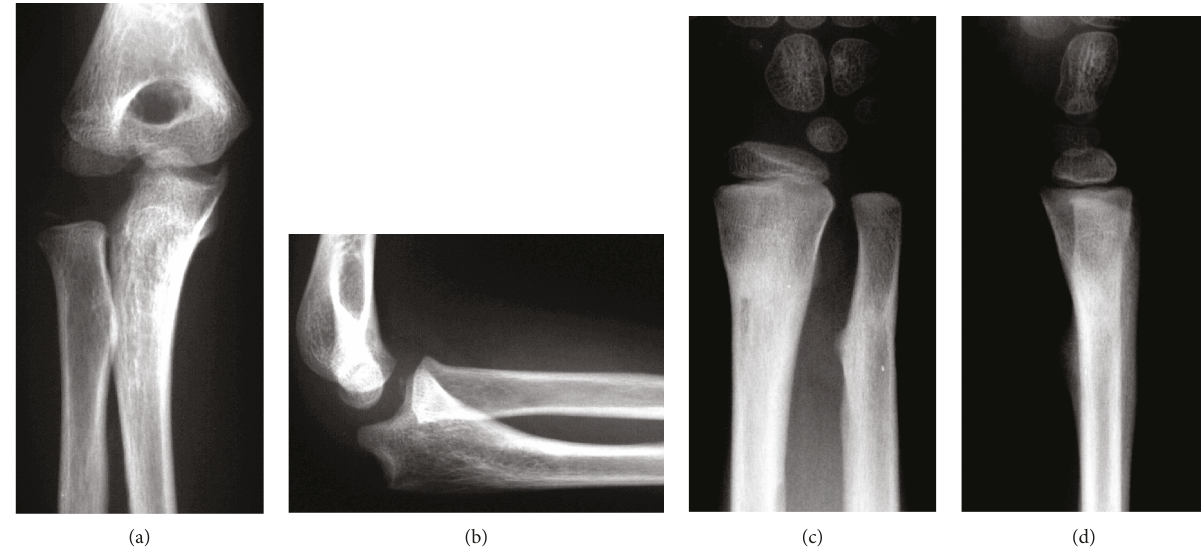
Figure 4: X-rays 3 months after surgery. (a) Front view of the elbow joint. (b) Lateral view of the elbow joint. (c) Front view of the wrist joint. (d) Lateral view of the wrist joint.